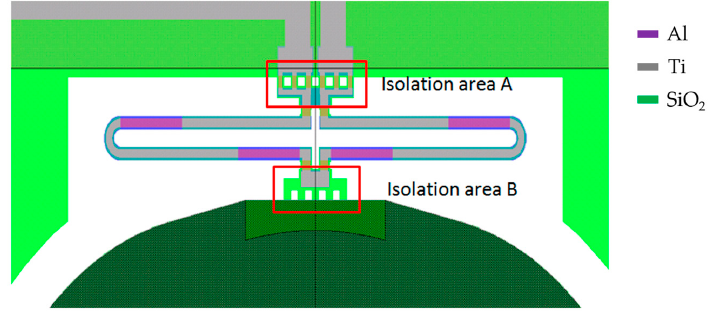
Figure 7. Schematic view of a single bimorph actuator design.